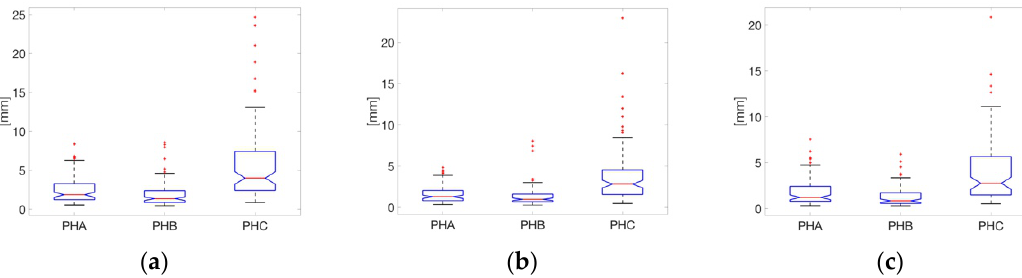
Figure 8. RMS distance distributions for each of the three phases PHA, PHB and PHC: (a) RDIST distributions, (b) RDISTX distributions and (c) RDISTY distributions.